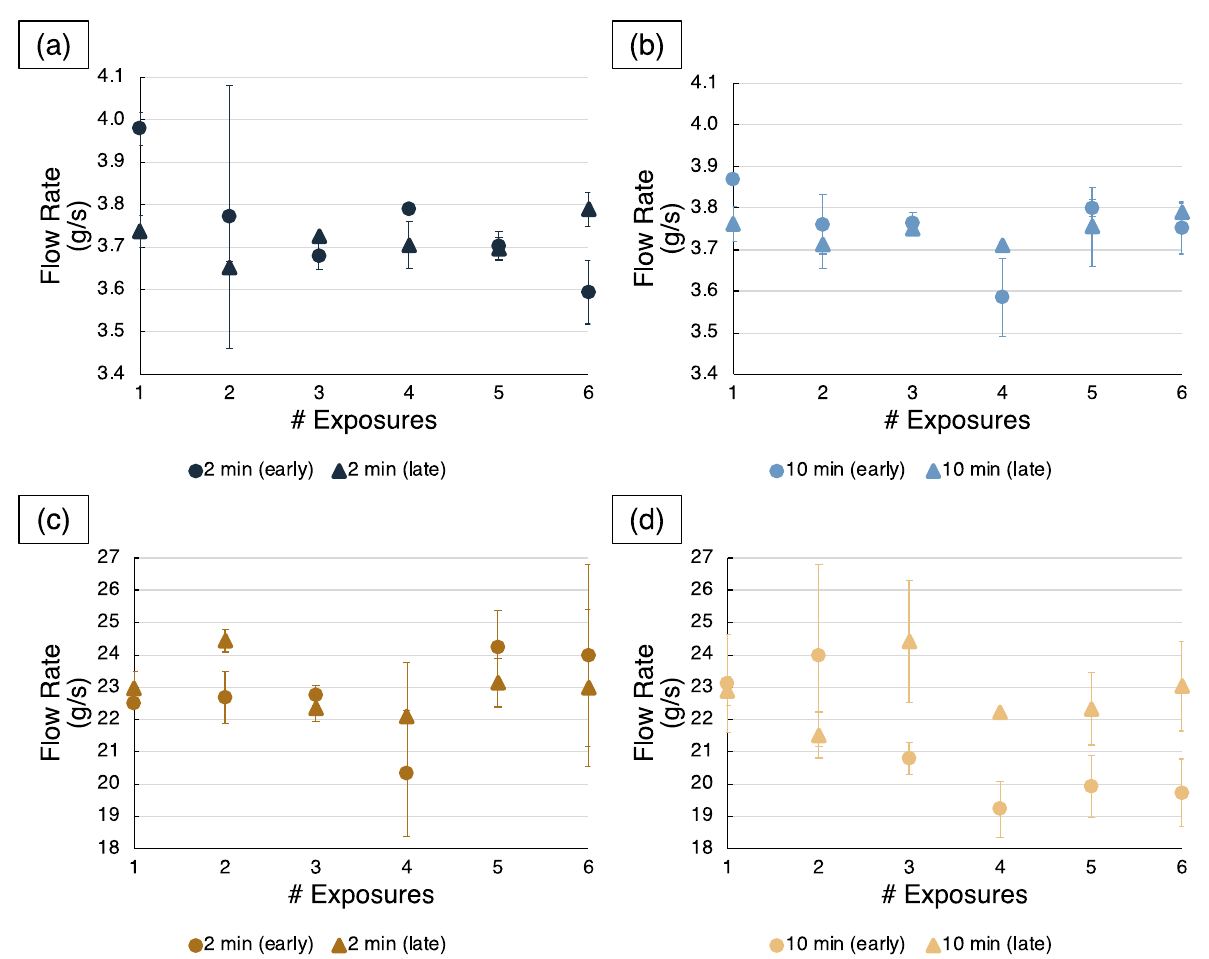
Figure 4. Flow rate (in g/s) of the Al 5056 powder at ( a ) 2 min and ( b ) 10 min exposure durations and the Ta powder at ( c ) 2 min and ( d ) 10 min exposure durations for the “early” and “late” exposures from Lots #1 through #6 and #13 through #18, respectively, for each powder type.